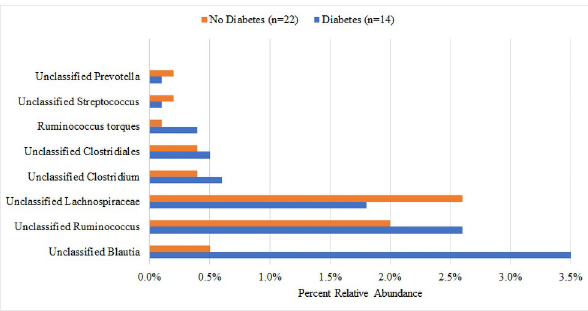
Fig 4. Percent relative abundance of the most abundant significantly different OTUs.